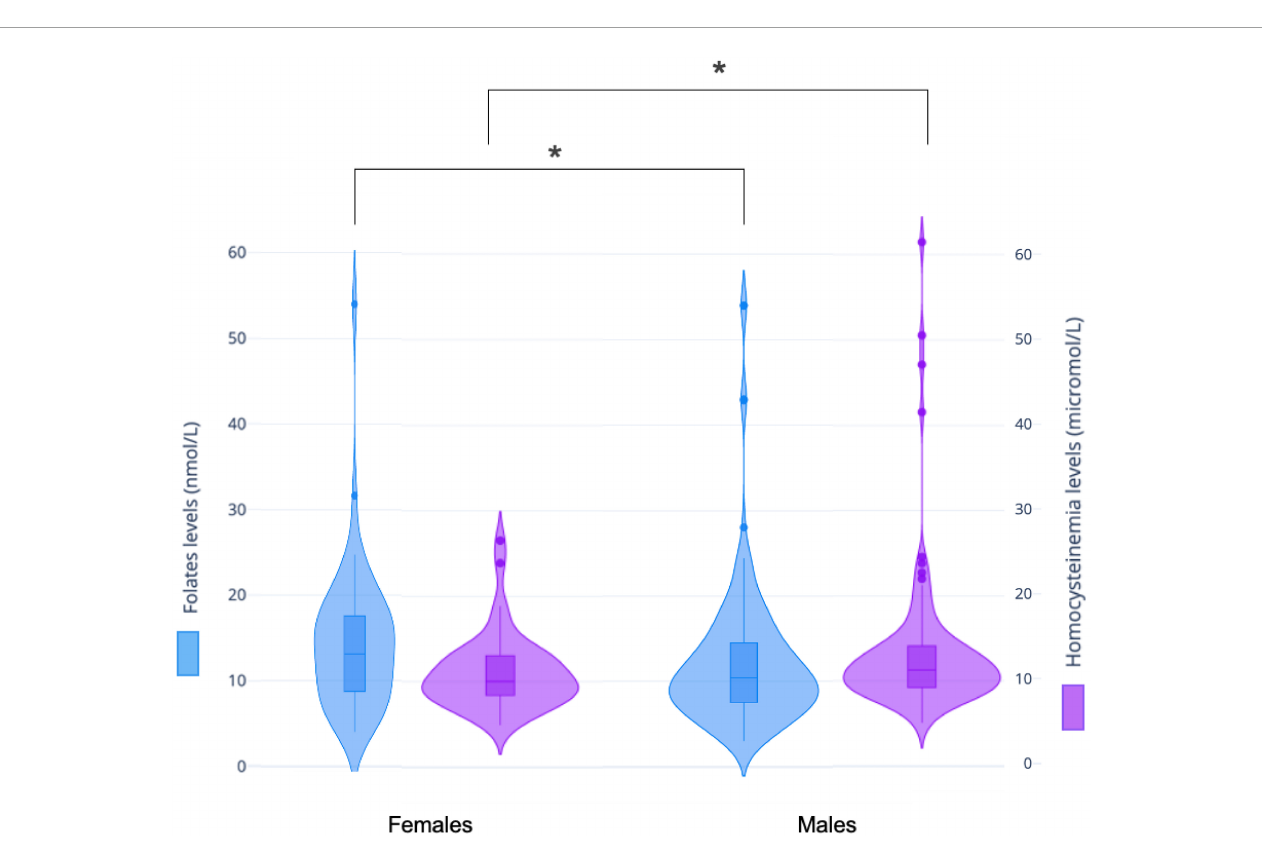
FIGURE3 Differences in one-carbon (C1) molecules levels between women and men. Violin and box plots presenting folates and homocysteine levels distribution in men and women. Men presented significantly lower average levels of folate compared to women (12.2 ± 8.2 versus 14.4 ± 8.2 nmol/L, p = 0.02, in blue). Men also presented significantly higher average levels of homocysteinemia compared to women (13.2 ± 8.1 versus 11 ± 4.3 µ mol/L, p = 0.05, in purple). * p <